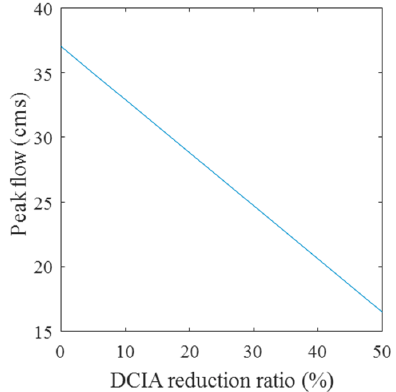
Figure 7. Peak flow as a function of DCIA reduction ratio at Shinweol 3 for the storm event on 19 July 2012.